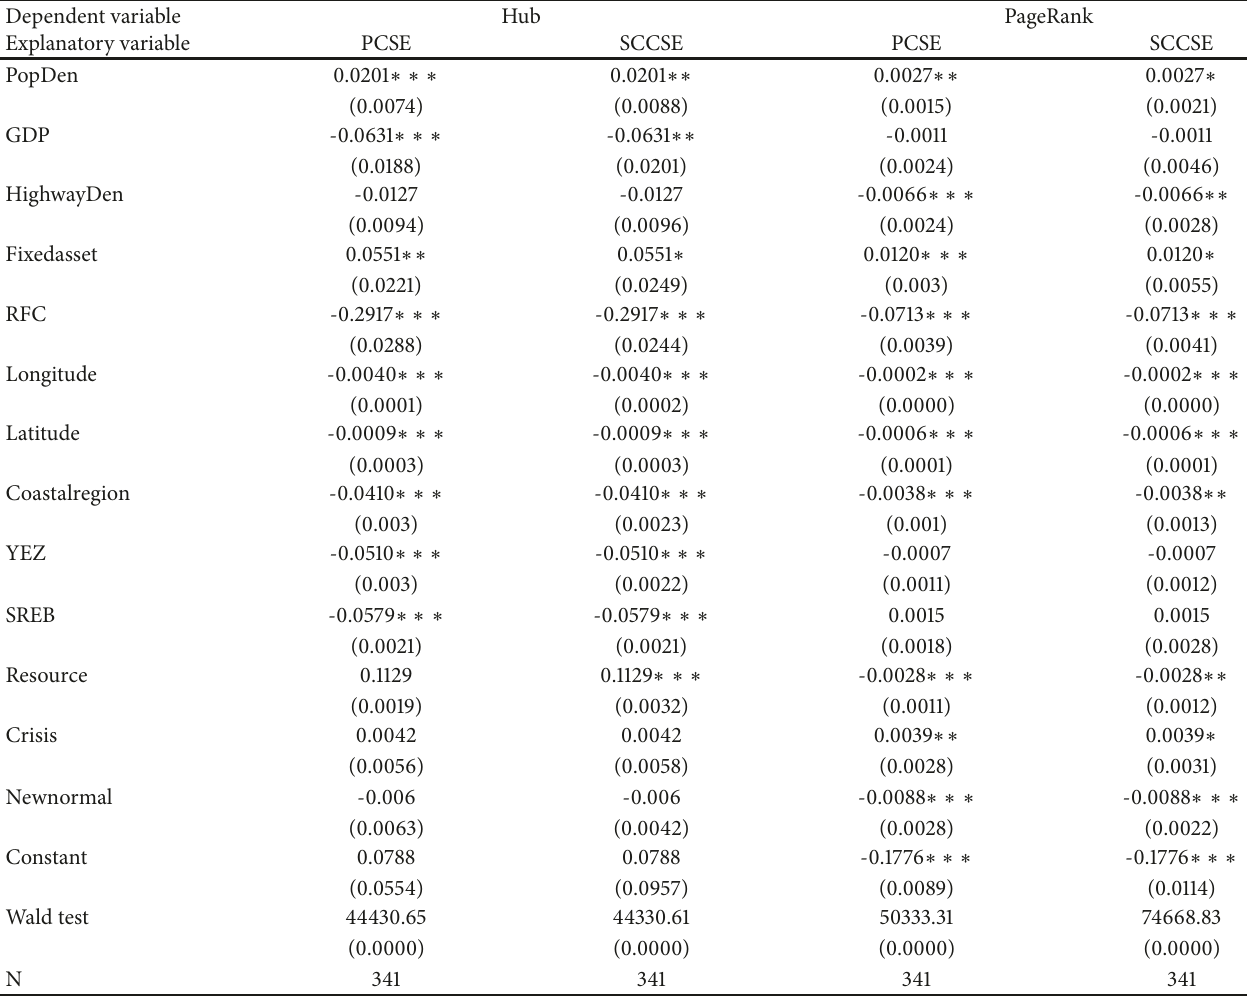
Table 6: Results of the determinants of Hub and PageRank using the PCSE and SCCSE